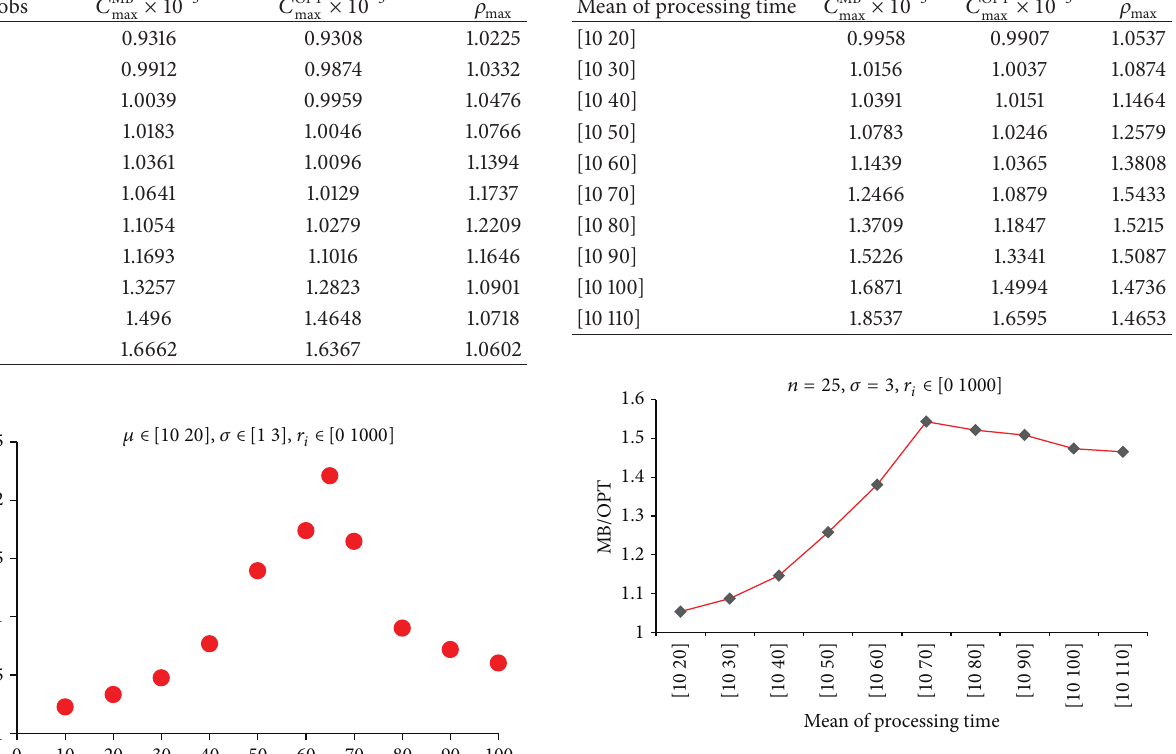
Figure 6: 𝜌 versus mean of processing